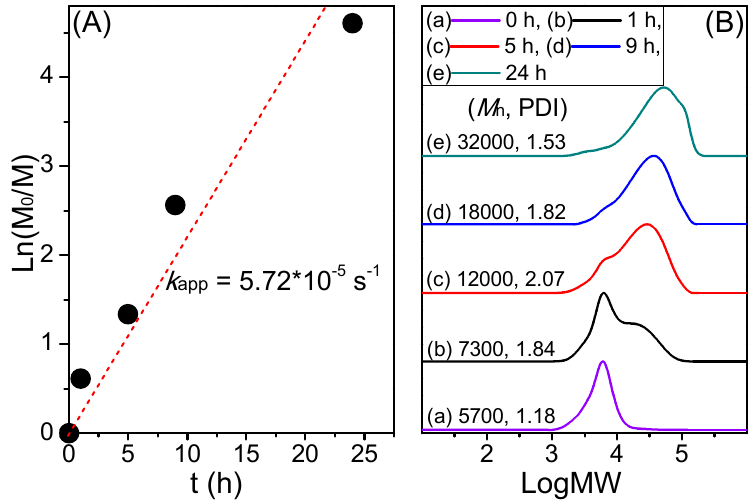
Figure 5. Chain extension of PCL-VBC 4 -PCL with tBA of ( A ) kinetic plots and ( B ) GPC traces (eluent: THF).